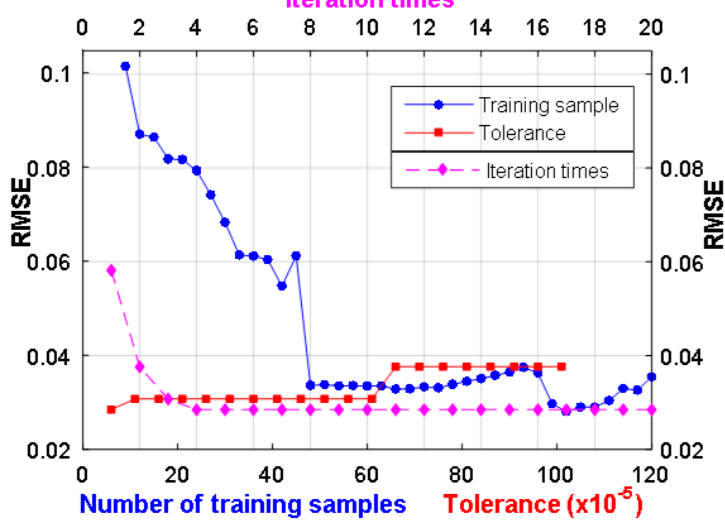
Figure 8. The impact of data fusion parameters on hyperspectral data